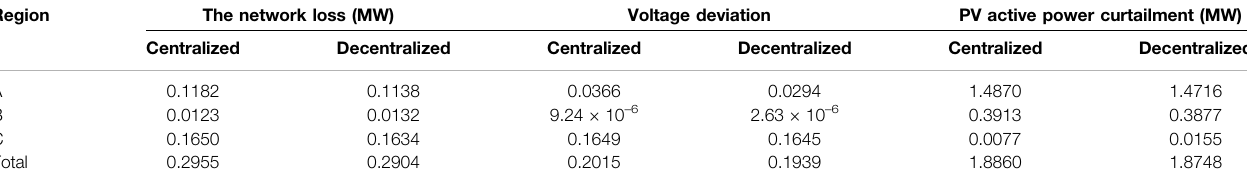
TABLE 2 | Comparison of results with different control methods. Region The network loss (MW) Voltage deviation PV active power curtailment (MW) Centralized Decentralized